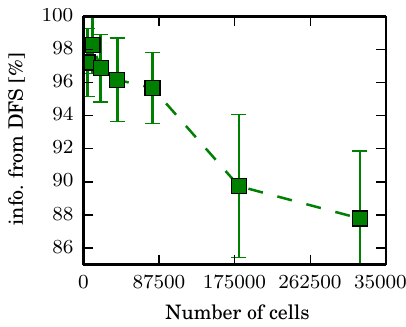
Figure 10. Information gathered from DFS. This is a benchmark to demonstrate that solution quality degrades with N cells and is not dependent on the